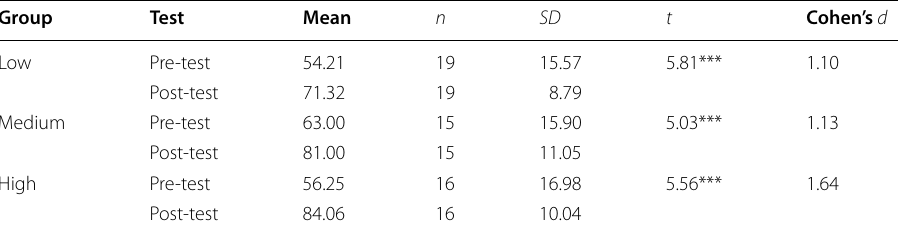
Table 5 Paired sample t test in web design skills of students in different knowledge integration